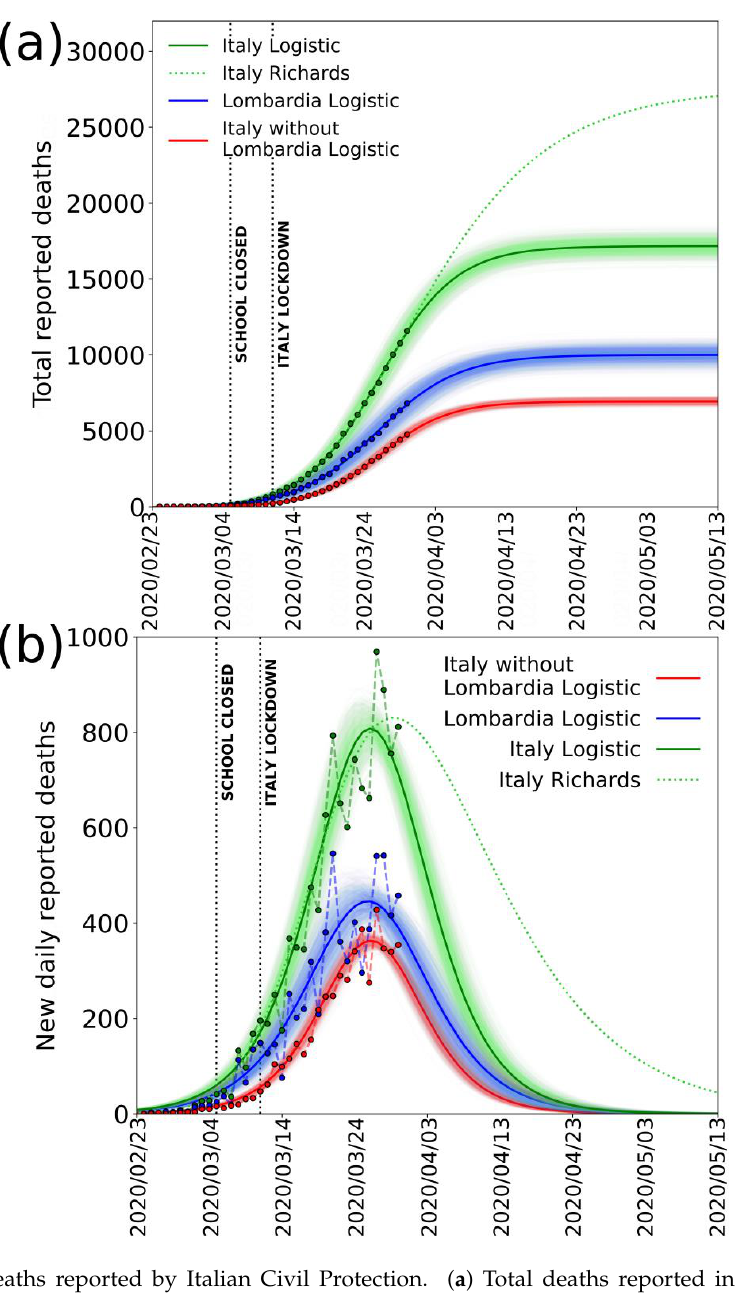
30, ν = 0.196 ± 0.004 )